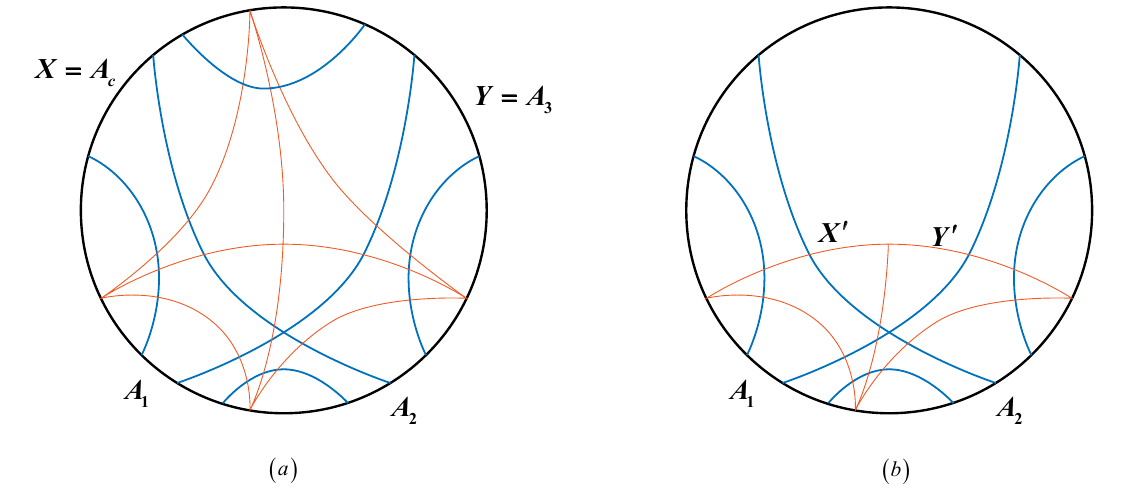
Figure 3 . (a) The locking bit thread configuration corresponding to the BPE, in which F 13 = F 2 c . (b) The locking bit thread configuration corresponding to the holographic EoP, in which there are only 5 component